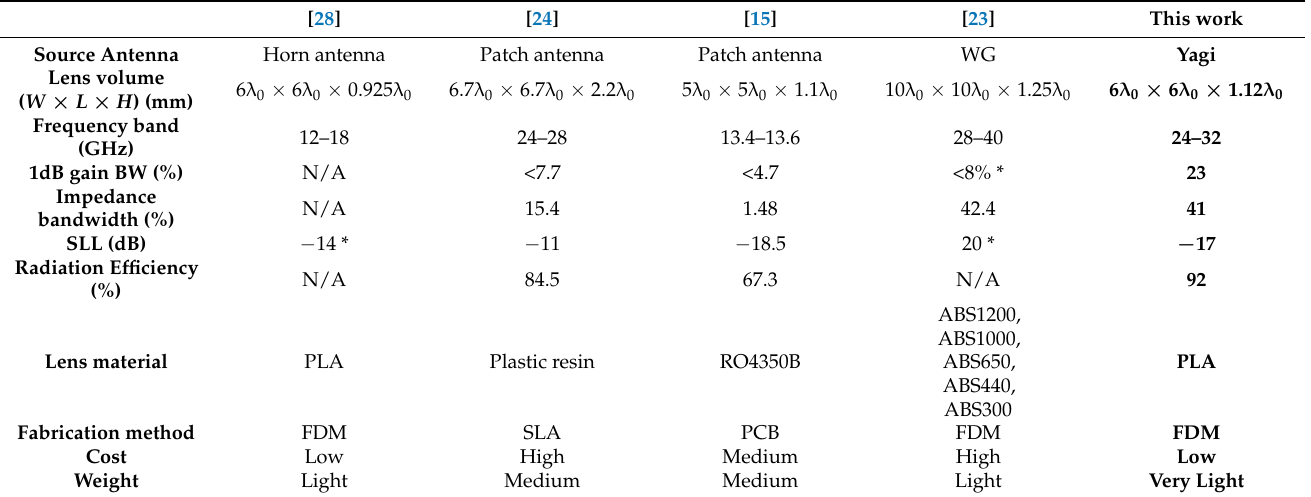
Table 2. Comparison of proposed fractal GRIN lens antenna and other millimeter-wave lens